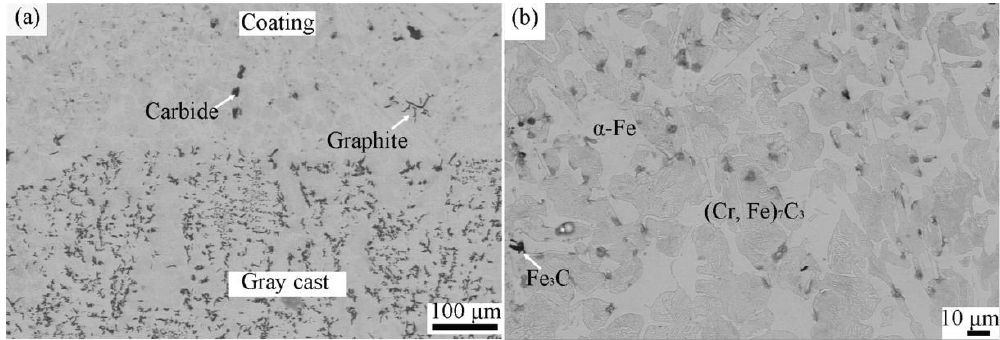
Figure 8. SEM images at the cross-section of the coating: ( a ) interface of coating and substrate and ( b ) microstructure of the coating.